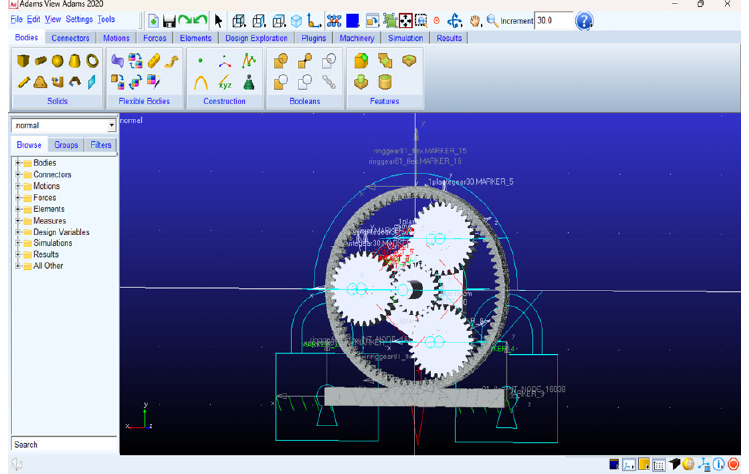
Figure 3. Rigid-flexible coupling multi-body dynamics model.